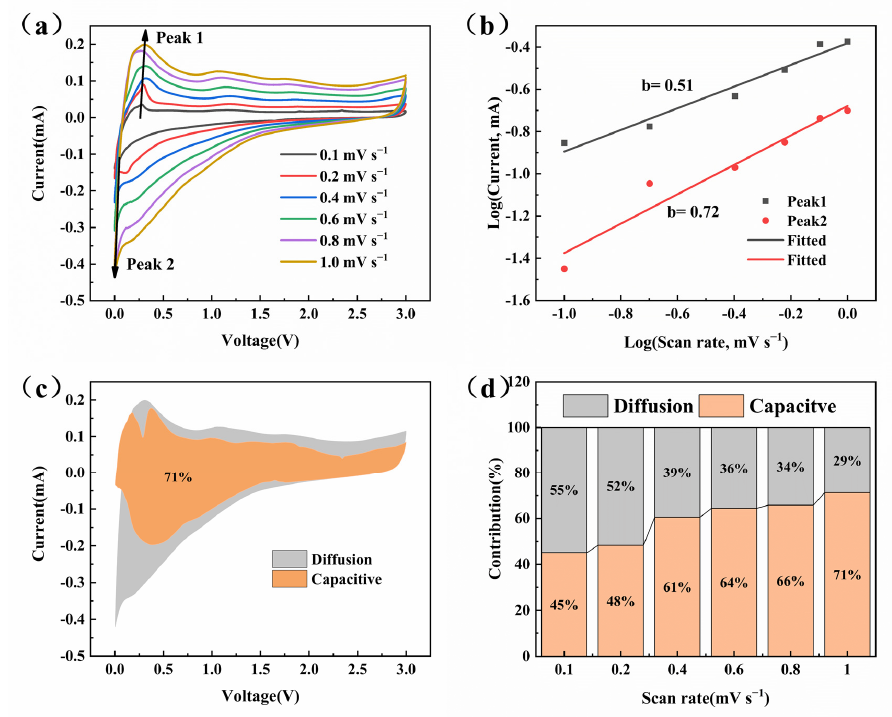
Figure 7. CV curves at different sweep rates ( a ), log (i) versus log (v) plots at around 0.01 V (lithia- tion) and at around 0.2 V (delithiation) ( b ), capacitive charge storage contribution (orange) and dif- fusion charge storage contribution (gray) at 1 mV s − 1 ( c ), normalized contribution ratio of capacitive (orange) and diffusion − controlled (gray) capacities at different scan rates ( d ) for C@Sn/NSGr − 7.5.